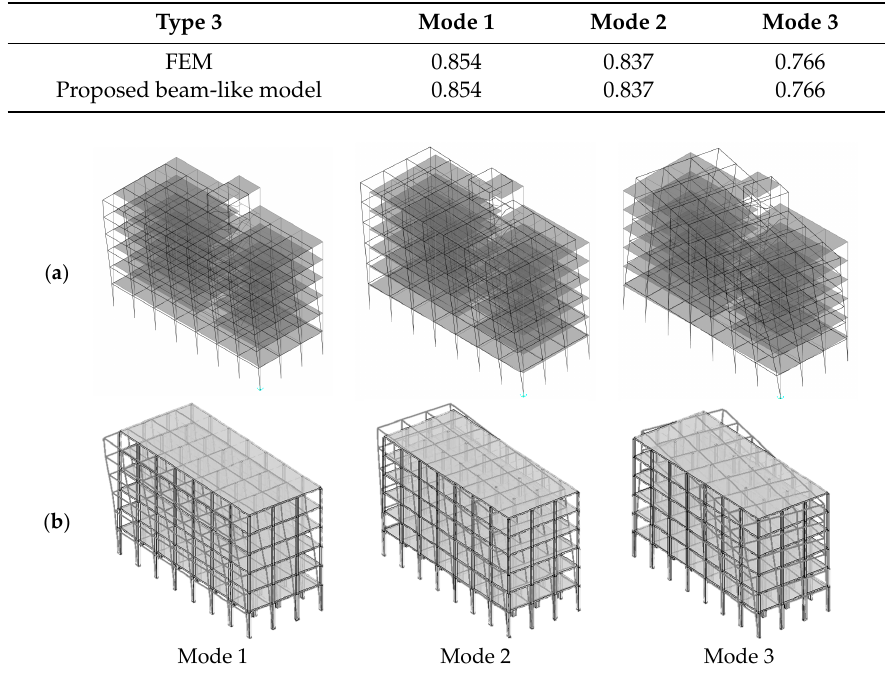
Figure 17. Six-storey benchmark. Modal shapes comparison between the ( a ) FEM and ( b ) beam-like models.